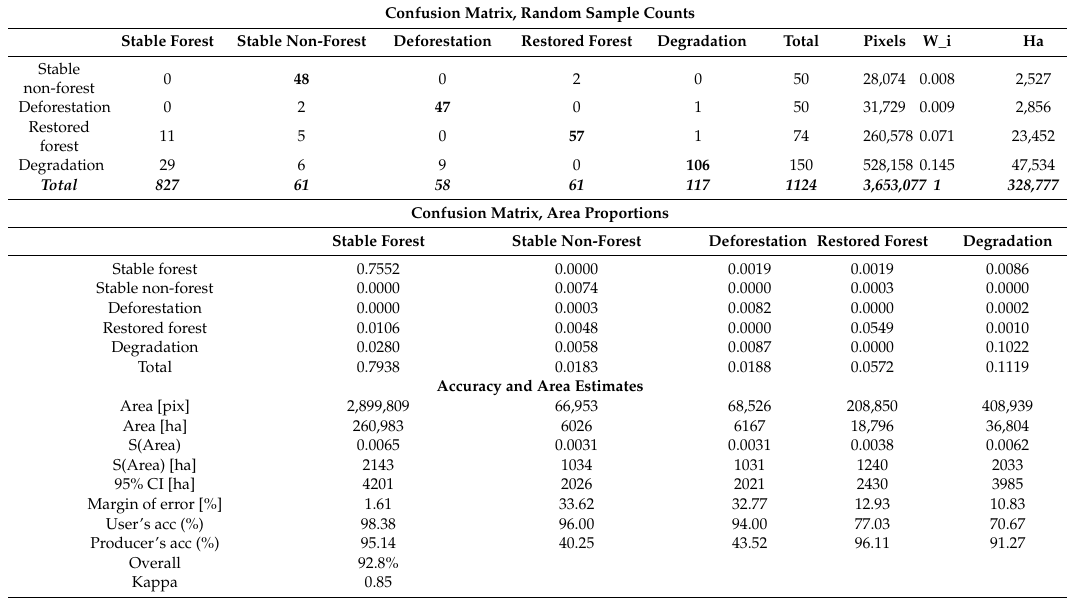
Table 4. Confusion matrix—sample counts, area proportions, area estimates, and accuracy measures for stable forest, stable non-forest, deforestation, restored forest, and forest degradation.